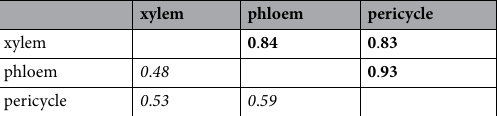
decoupled models for all three scenarios (Table 2: Li 1, Table 3: Li 2 and Table 4: Birnbaum). The decreasing sim- ilarity of pairwise considered correlation matrices demonstrated again that the coupled context-specific models were more specific than their decoupled counterparts.